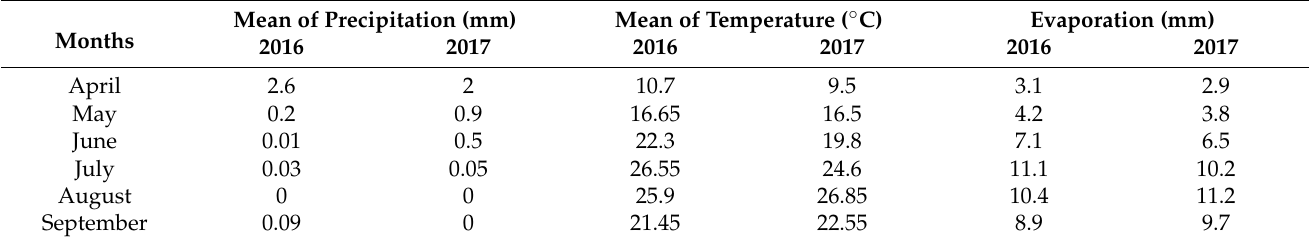
Table 1. Mean values of rain and temperature of Zanjan weather station in 2016 and